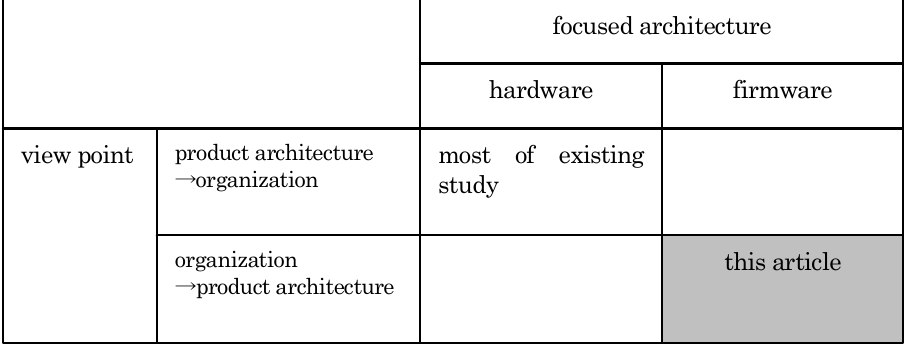
Figure 1. Investigation area covered in this